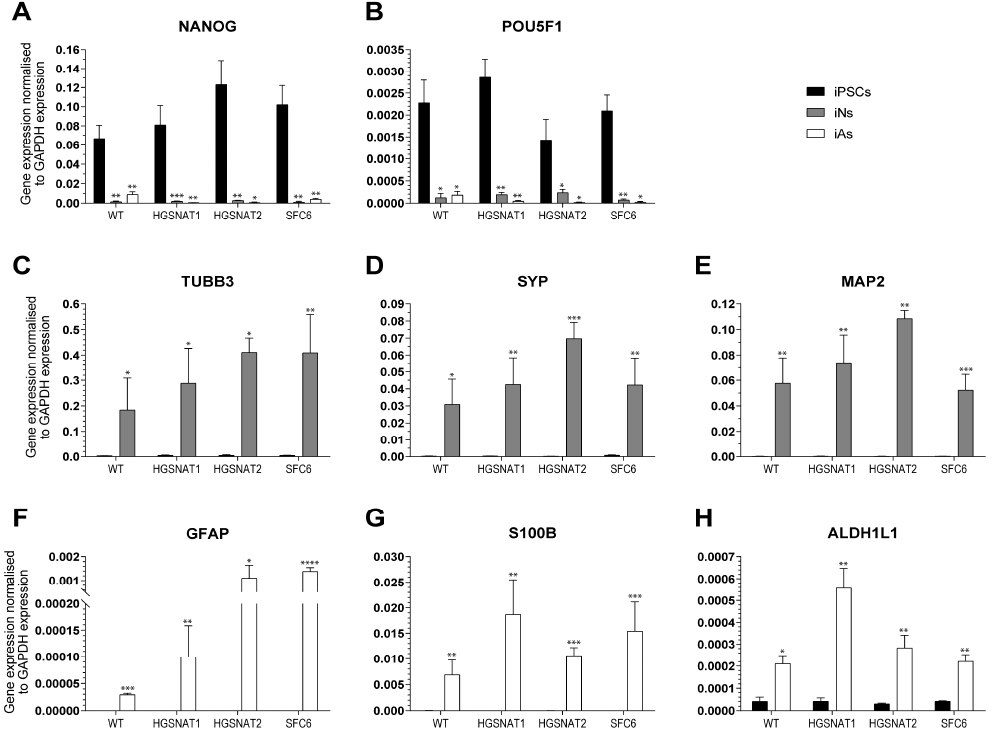
Figure 2. Cell-type-specific marker expression measured by qPCR in iPSCs (black), iNs (grey), and iAs (white) from all lines: WT, HGSNAT1, HGSNAT2, and SFC6. NANOG ( A ) and POU51F1 ( B ) are iPSC-associated markers; TUBB3 ( C ), SYP ( D ), and MAP2 ( E ) are neuronal-specific markers; and GFAP ( F ), S100B ( G ), and ALDH1L1 ( H ) are characteristic markers for astrocytes. Gene expression is normalized to GAPDH expression. Data are shown as the mean ± s.e.m. from three independent experiments with two technical replicates. **** p value < 0.0001, *** p value < 0.001, ** p value < 0.01, * p value < 0.05, ratio paired t-test comparing iPSC vs. iN or iAs.